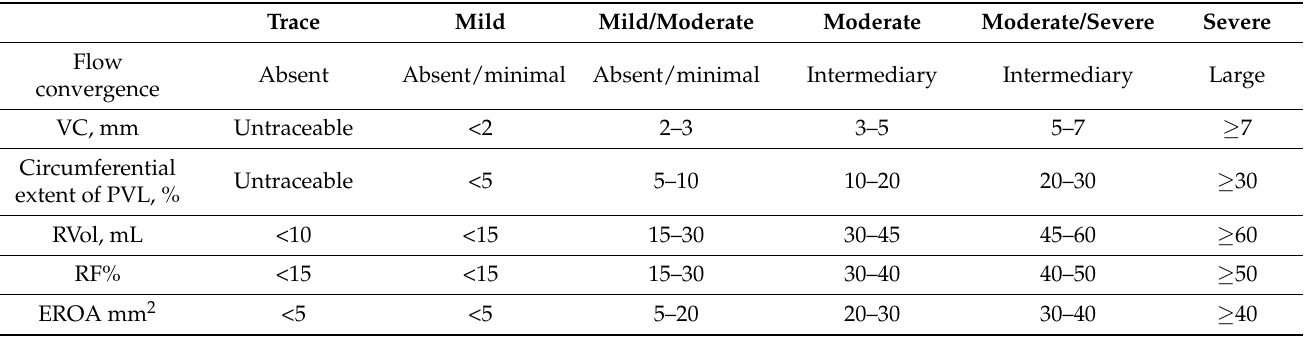
Table 2. Selected echocardiography parameters useful for mitral PVL grading